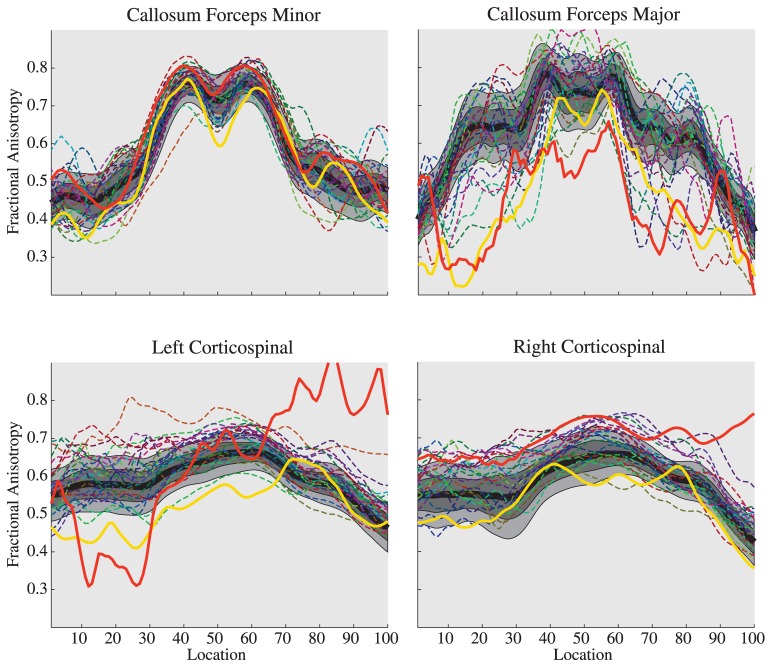
Individual Tract FA Profiles for children born preterm compare to Standardized Tract FA Profiles for typically developing children.For four tracts, Tract FA profiles of individual preterm patients are plotted as a dashed line. Each patient is a different color. Notice the substantial variation in Tract FA profiles, particularly in the callosum forceps major and left corticospinal tract. Two patients (red and yellow solid lines) have unusual Tract FA profiles that correspond to clinical findings (discussed in main text).